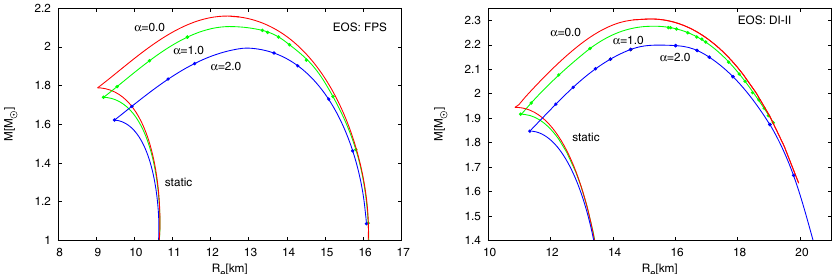
Fig. 7 The physical regime on the mass-circumferential equatorial radius plane for neutron star solutions in EdGB theory for the FPS (left) and DI-II (right) EOSs. The left boundary in each panel designates the static sequence and the upper and right boundary the mass-shedding sequence. The values of the coupling constant α = 0 , 1 , 2 are in units of M 2 (cid:3) . (Image reproduced with permission from Kleihaus et al. 2016, copyright by